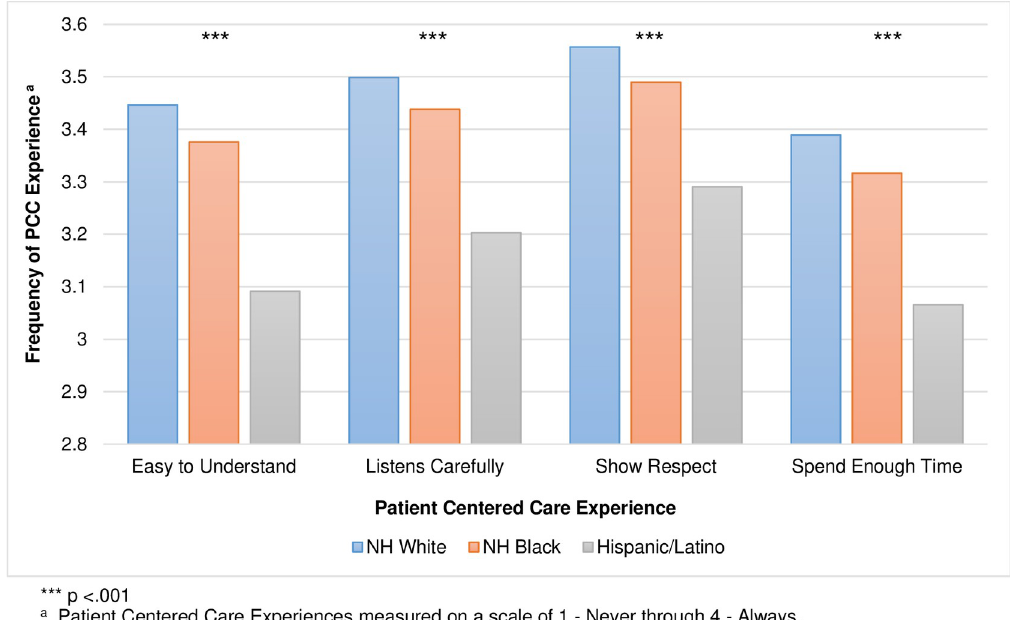
Fig 1. Reported Patient Centered Care (PCC) experiences by